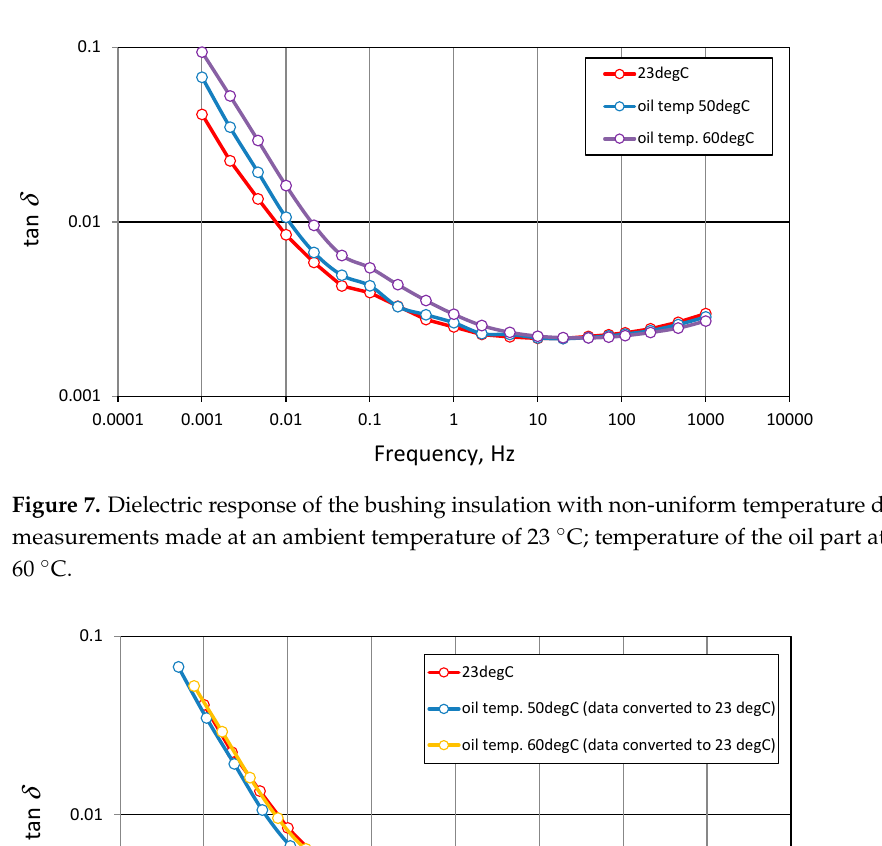
Figure 7. Dielectric response of the bushing insulation with non-uniform temperature distribution; measurements made at an ambient temperature of 23 °C; temperature of the oil part at 50 °C and 60 °C.